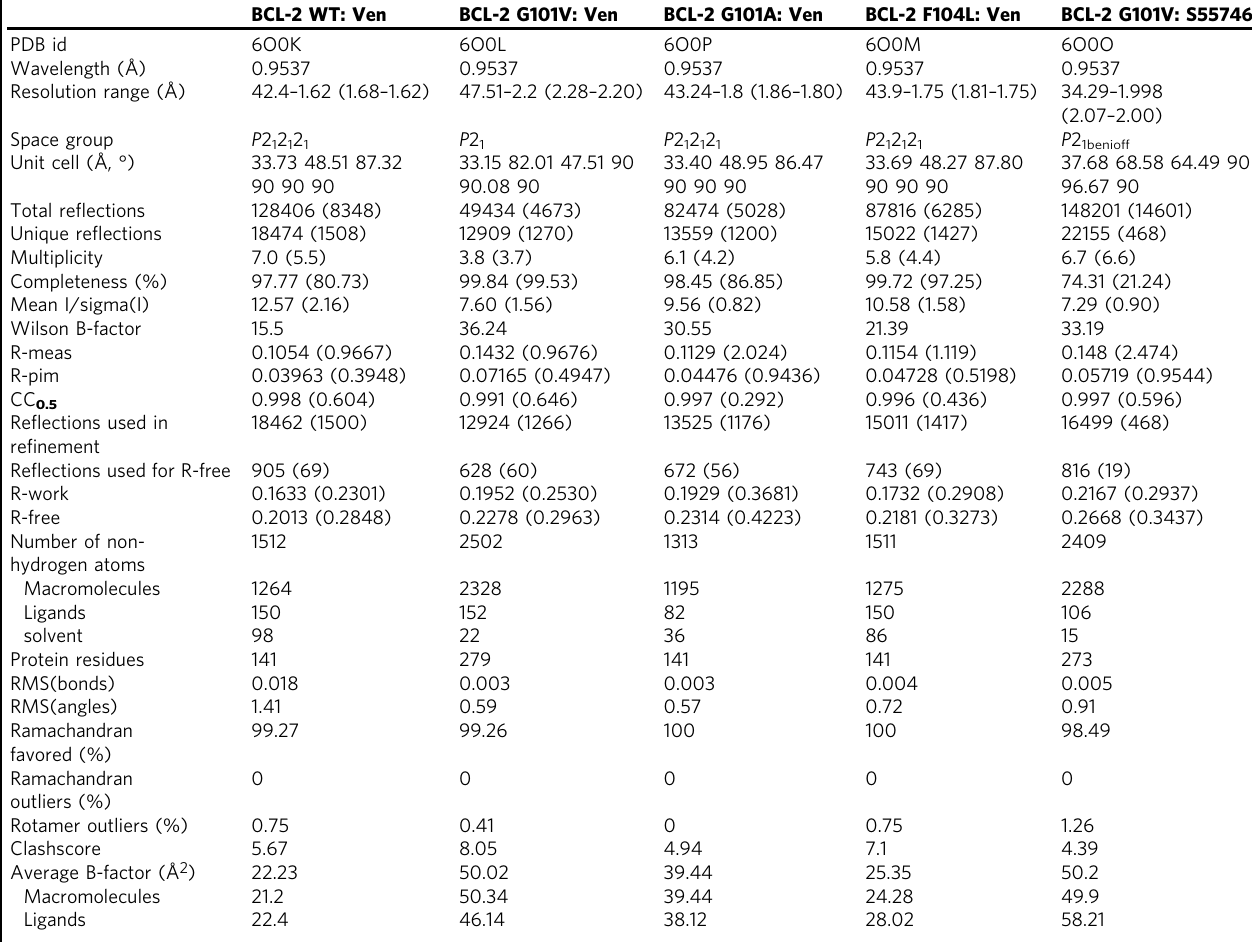
Statistics for the highest-resolution shell are shown in